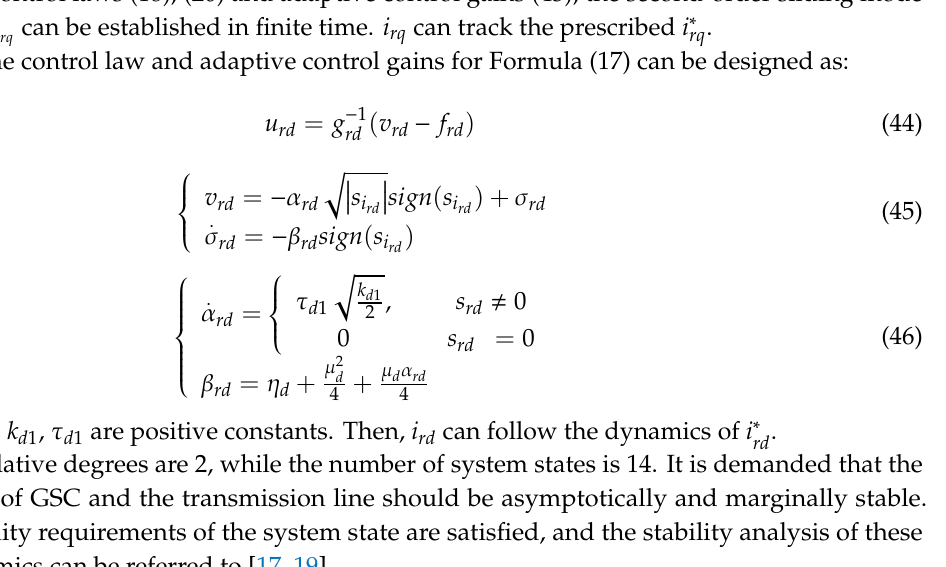
Figure 3. Space vector PWM (SVPWM) is employed to achieve a constant switching frequency.